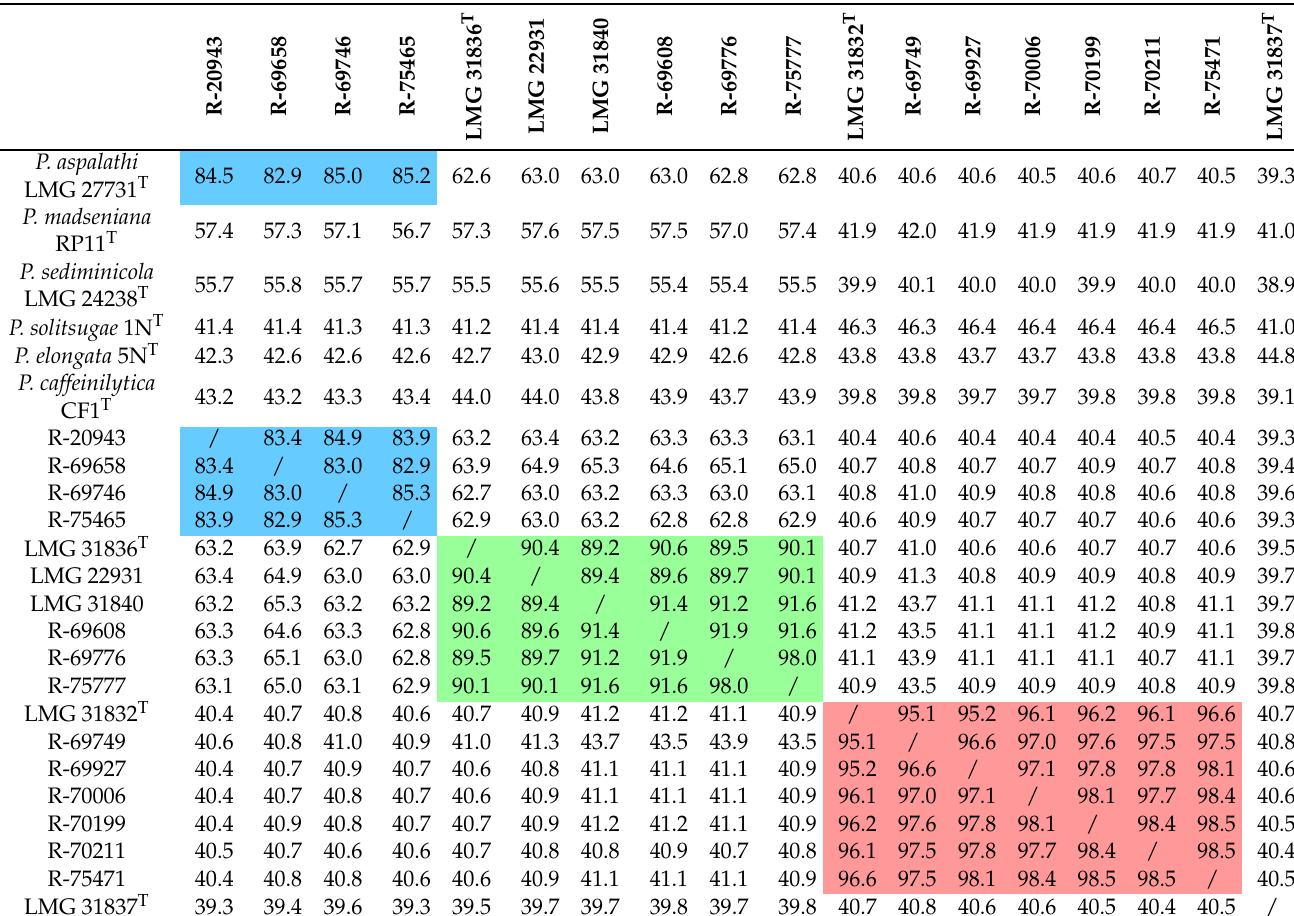
Table 2. Pairwise dDDH (%) values between strains of the present study and their closest phylogenetic relatives. Values of 70% or higher were highlighted in color according to their respective clusters (Figure 2); A, blue; B, green; C,